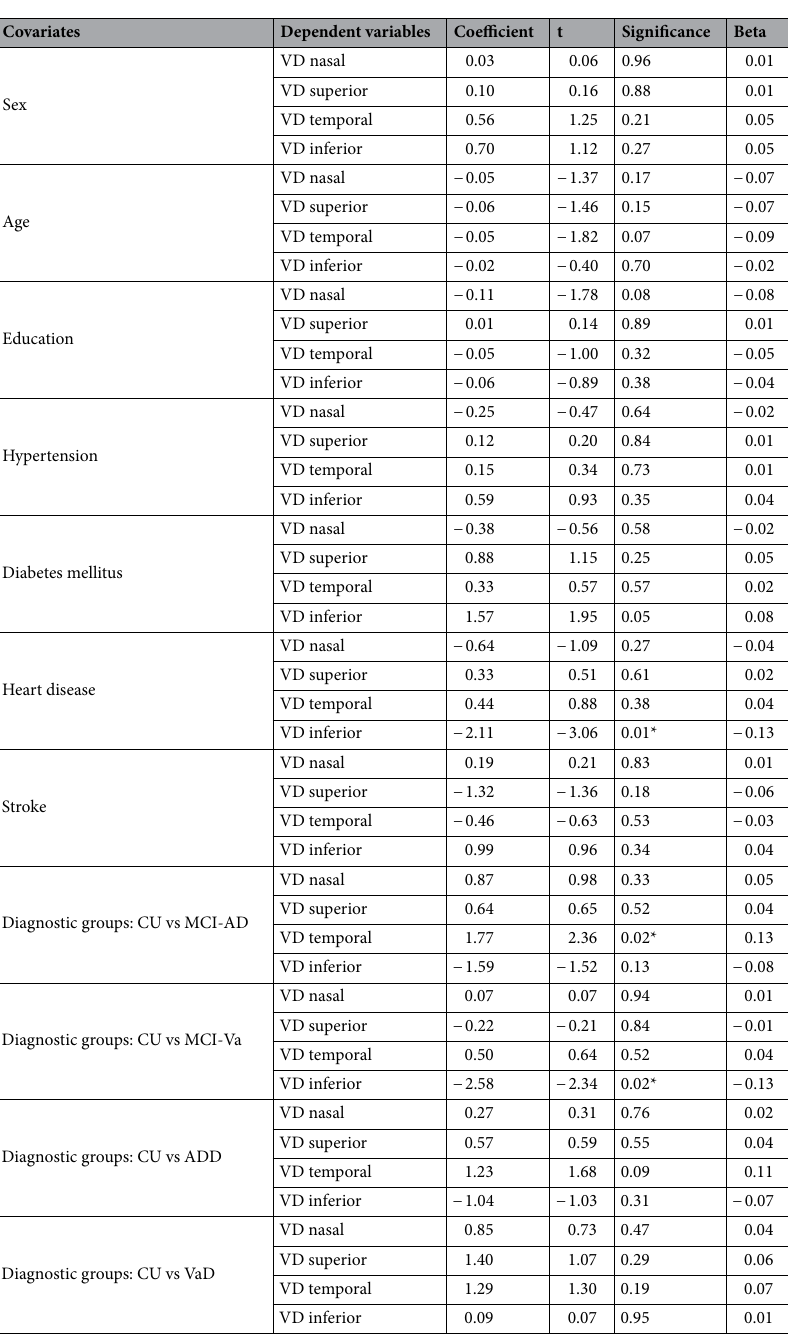
Table 2. Multivariate regression analysis of macular VD measurements. The multivariate regression analysis included the following adjusting factors: age, sex, years of education, hypertension, diabetes